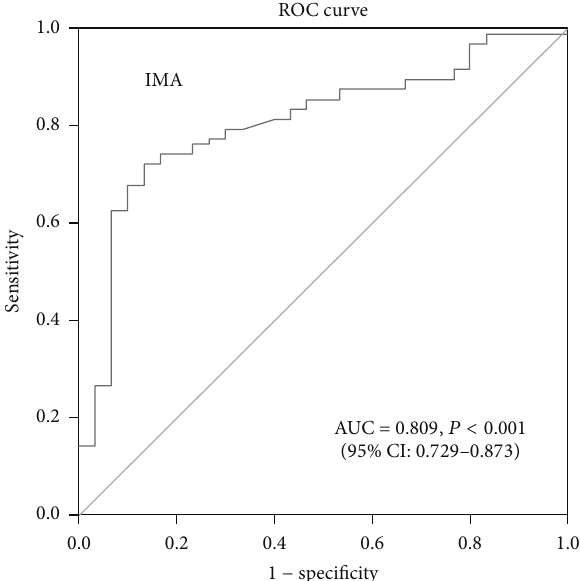
Figure 1: Receiver operating characteristics (ROC) curve analysis for cut-off value of 0.467 ABSU for IMA. IMA: ischaemia-modified albumin; AUC: area under the curve; CI: confidence